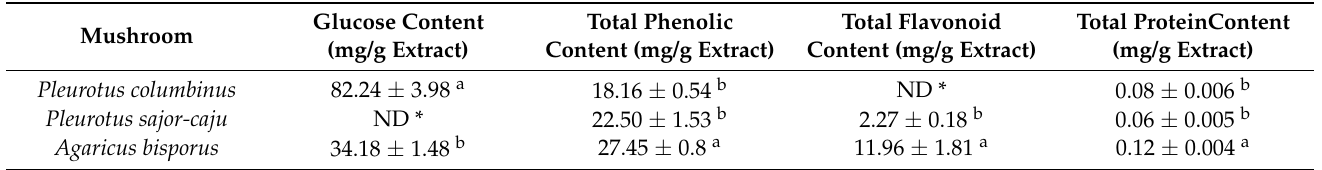
Table 1. Biochemical characterization of the three mushroom extracts.